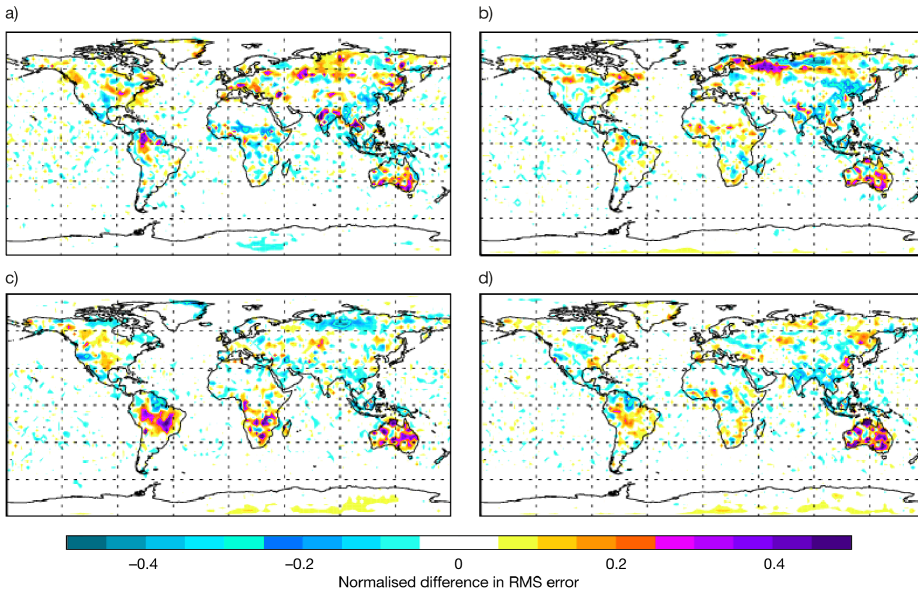
Figure 12. 2 m temperature normalised RMSE difference between forecasts using the seasonal vegetation cover (FSCV) and the control simulations with static vegetation cover (CTR) for ( a ) DJF, ( b ) MAM, ( c ) JJA and ( d )